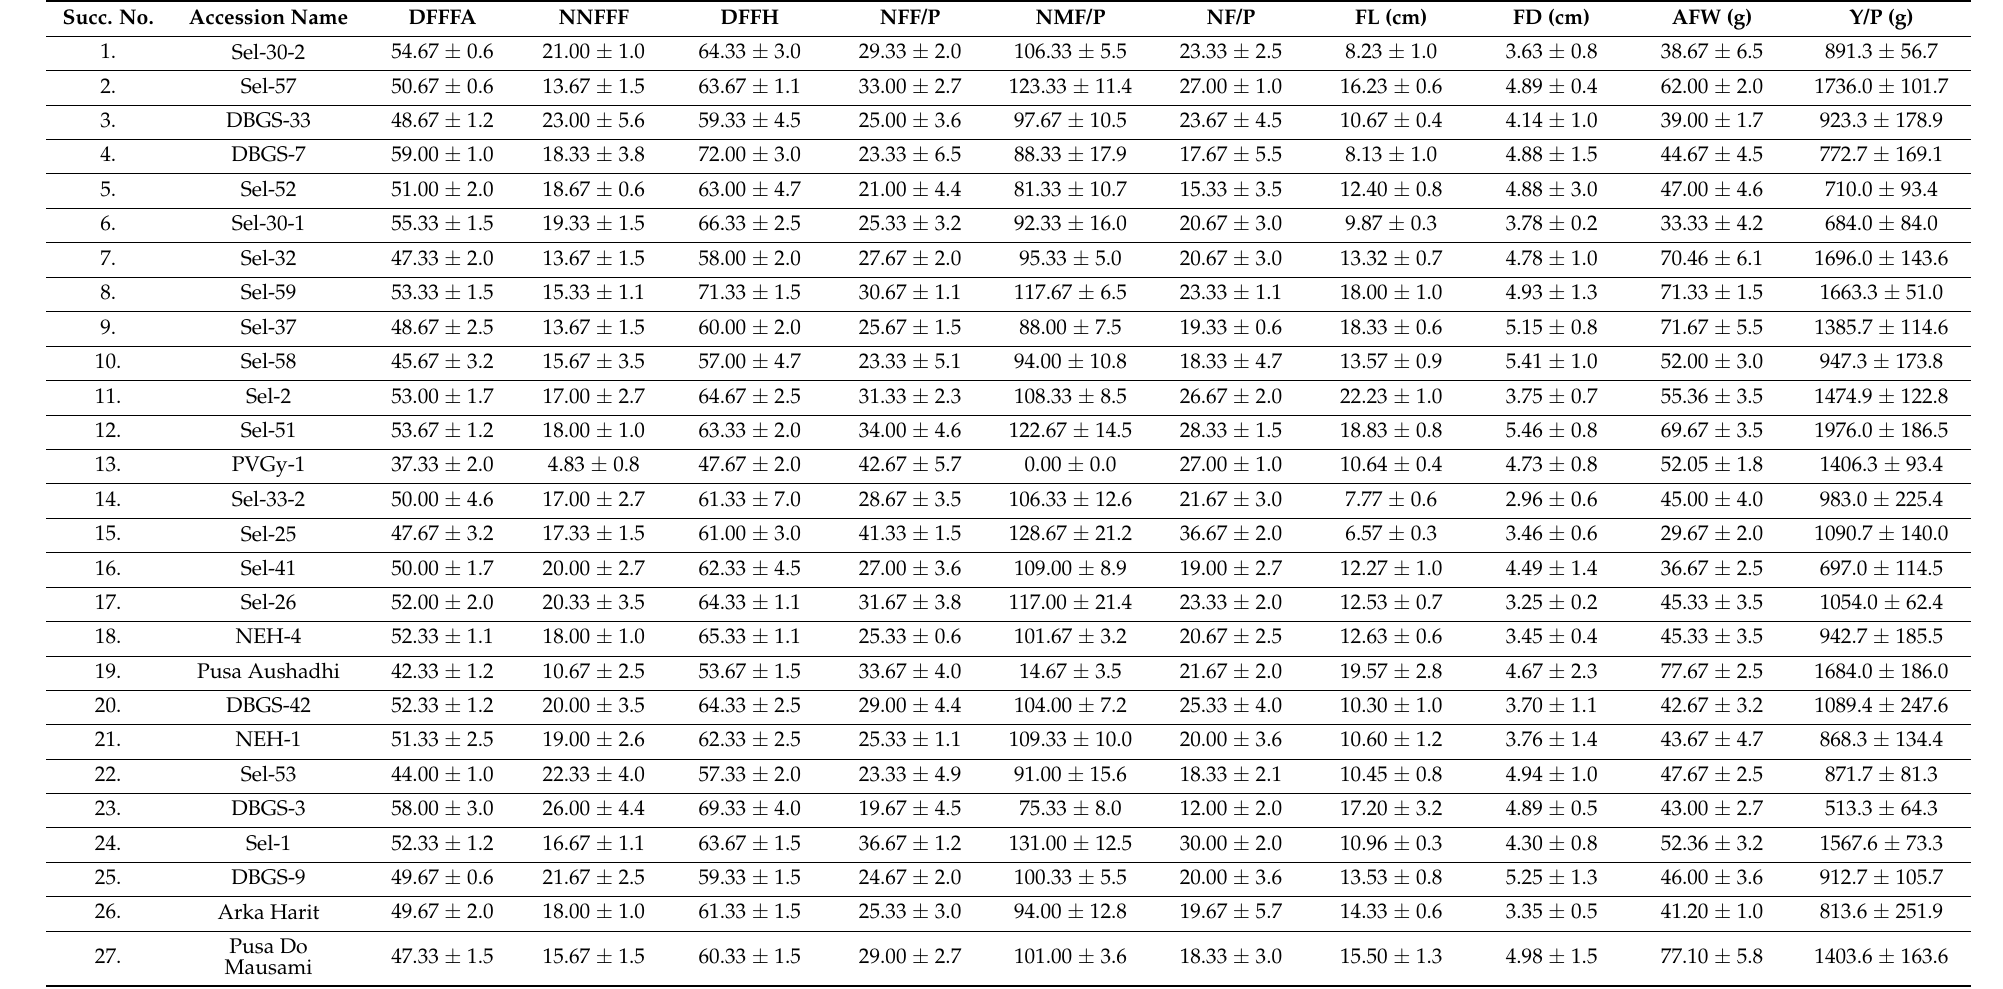
Table 1. Performance of 51 accessions of Momordica charantia in terms of earliness and yield characteristics. Succ.